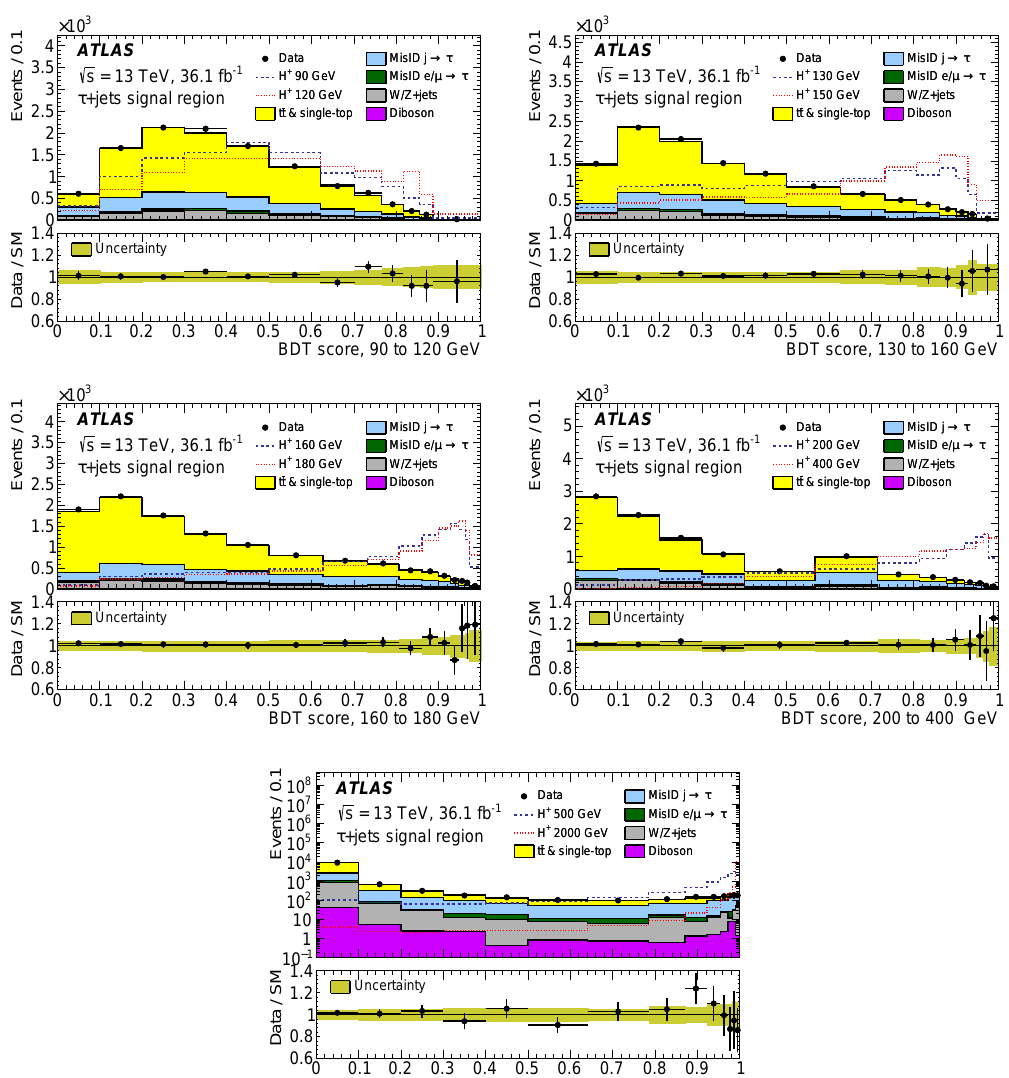
+ jets channel, in h